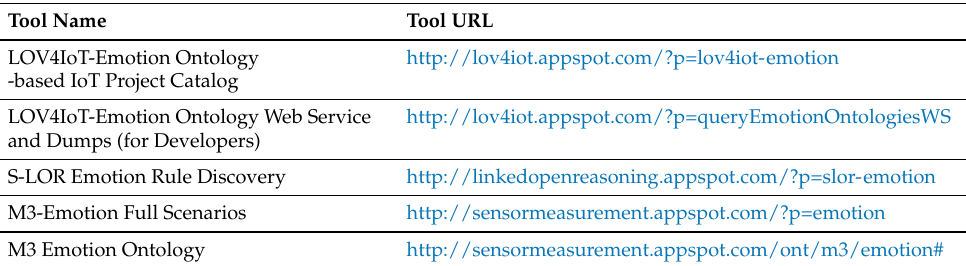
Table 6. Set of online demonstrators: ontology catalog, rule discovery, and full scenarios. accessed on